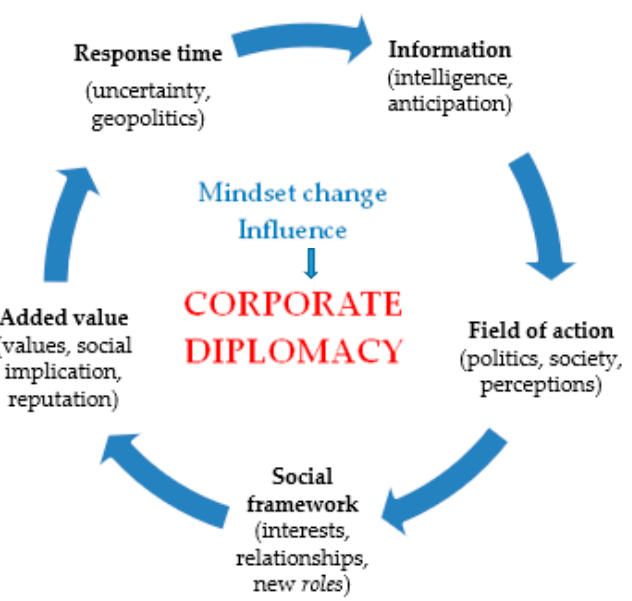
Figure 1. Vectors to consider for a corporate mindset change. Source: Egea et al., (2017) [13] (p. 37).